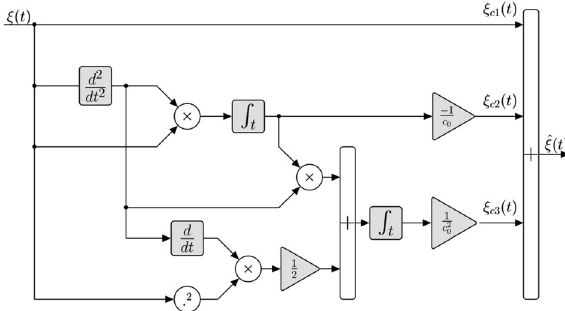
Figure 10. Continuous time realisation structure of D H trun- cated at N = 3, built from the transfer kernels D H structure is composed of products and sums of differentiators and integrators.